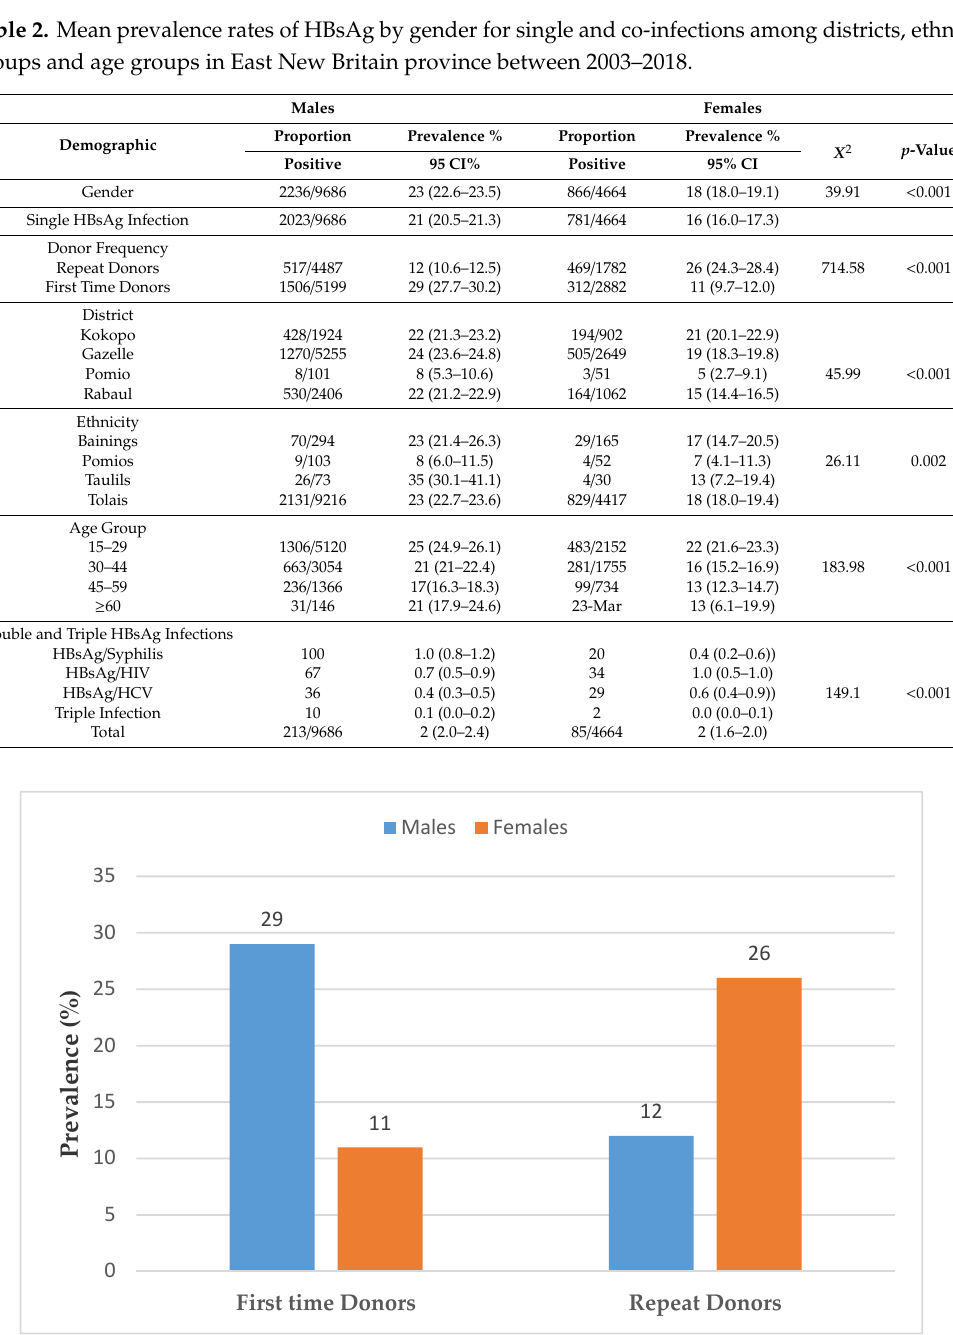
Figure 5. Proportion of HBsAg positive first time and repeat blood donors between 2003–2018.